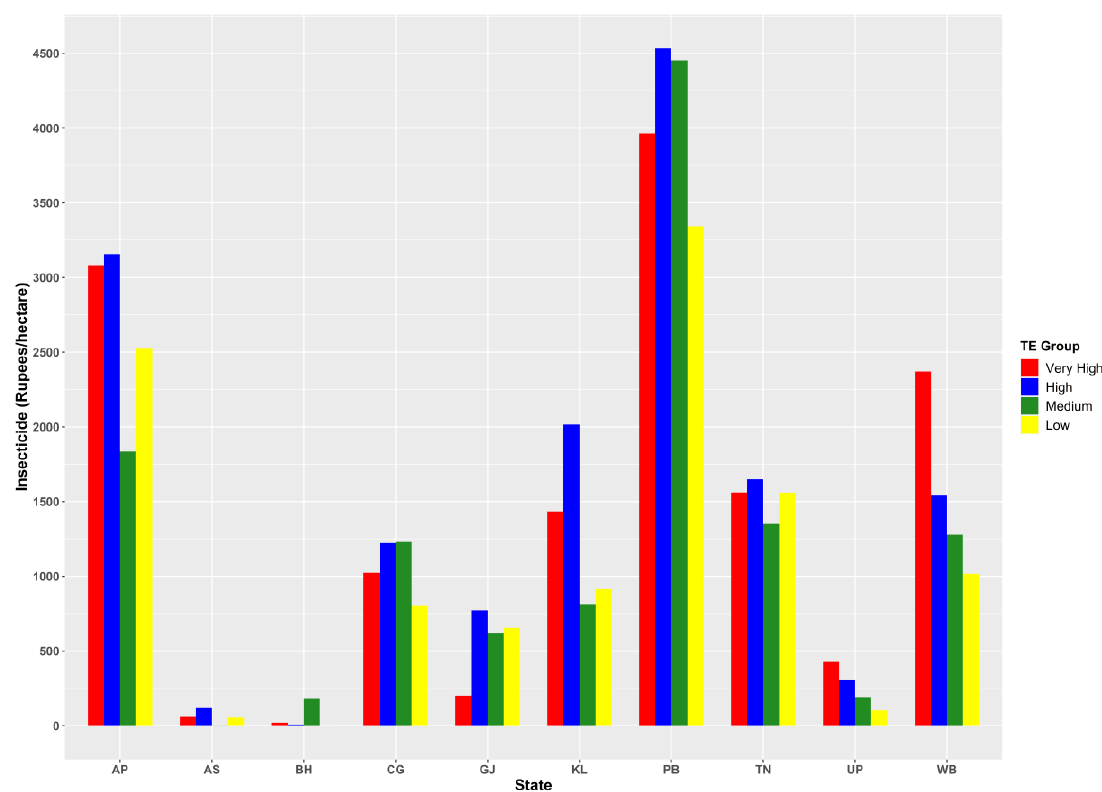
Figure 6. Insecticide use in paddy (rupees/hectare) across various states and efficiency groups.